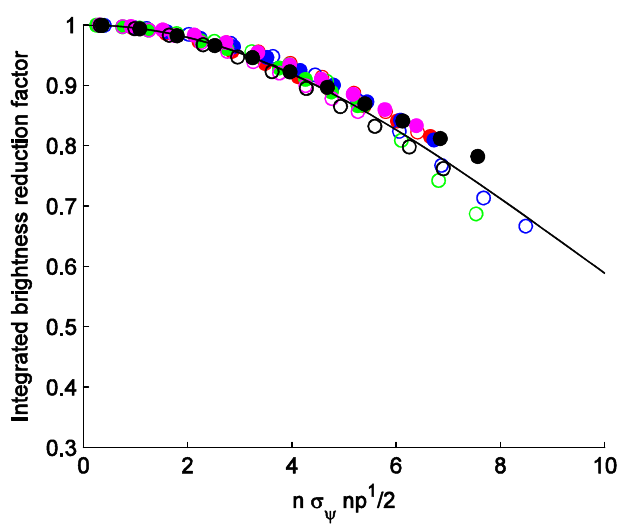
FIG. 17. As Fig. 16 (lower right), after removing the effect of phase